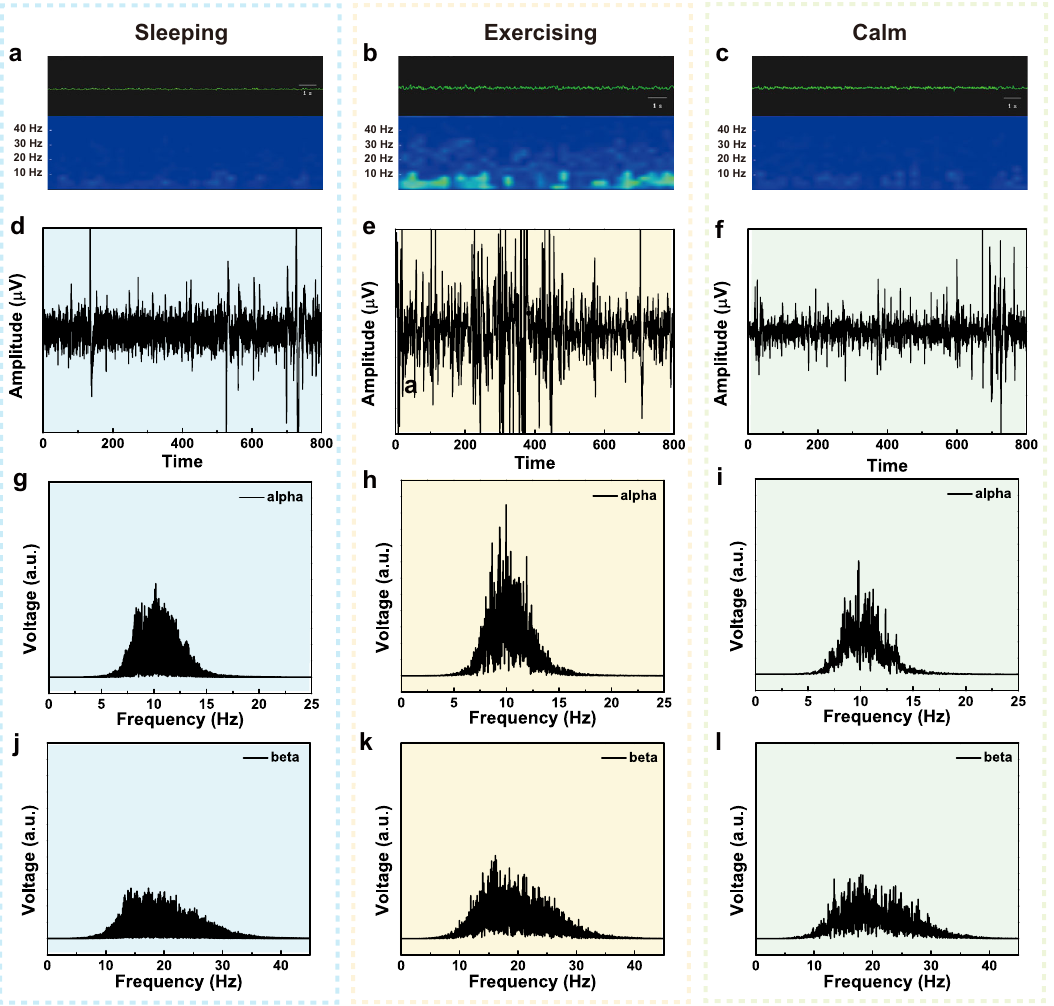
Fig. 7 Long-time monitoring of EEG. a – c Original EEG signals, d – f fast Fourier Transformed EEG signals, g – i the extracted alpha waves and j – l beta waves when the volunteer was at status of sleeping, exercising (skipping rope) and recovering to calm state after ~1